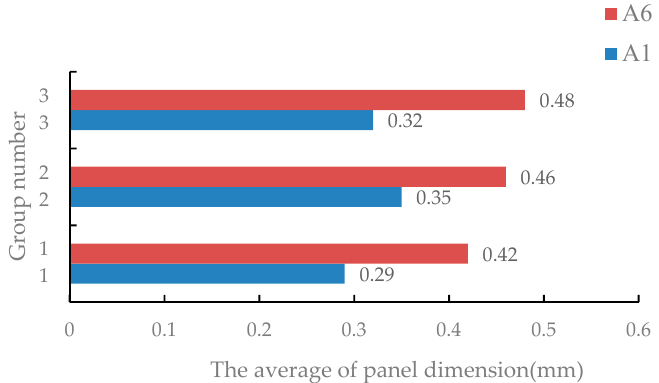
Figure 10. Effect of veneer thickness on panel dimension.